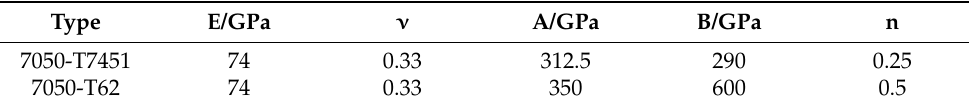
Table 1. Elastic and Plastic Properties for Sheet and Rivet Materials.